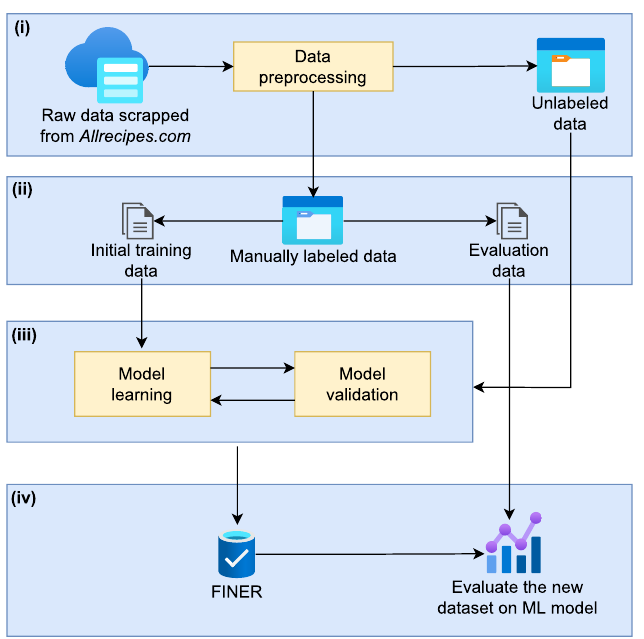
Figure 1. FINER dataset construction